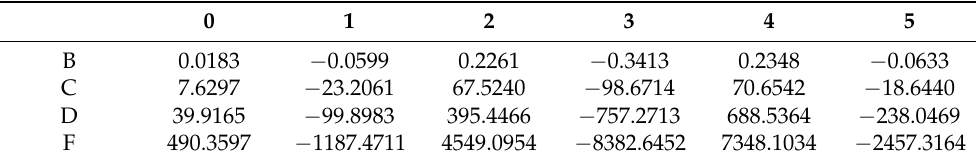
Table 4. Coefficients of polynomial fitting curves for material